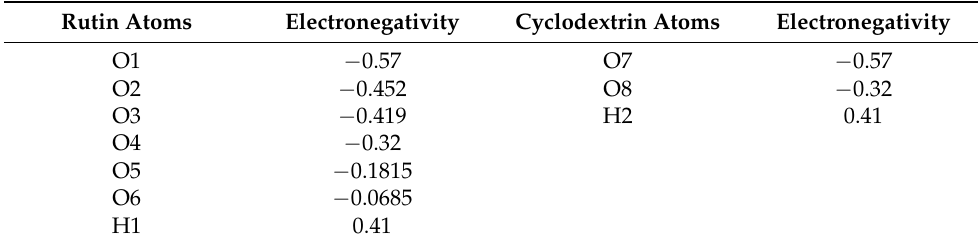
Table 6. Atomic charge distribution of rutin and